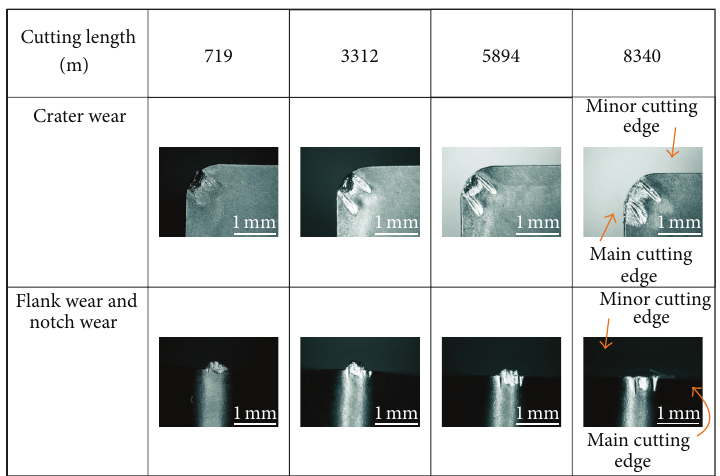
Figure 1: Overview of wear evolution for the cutting parameters 𝑣 𝑐 = 100 m/min, 𝑓 = 0.25 mm/rev, and 𝑎 𝑝 = 0.1 mm.